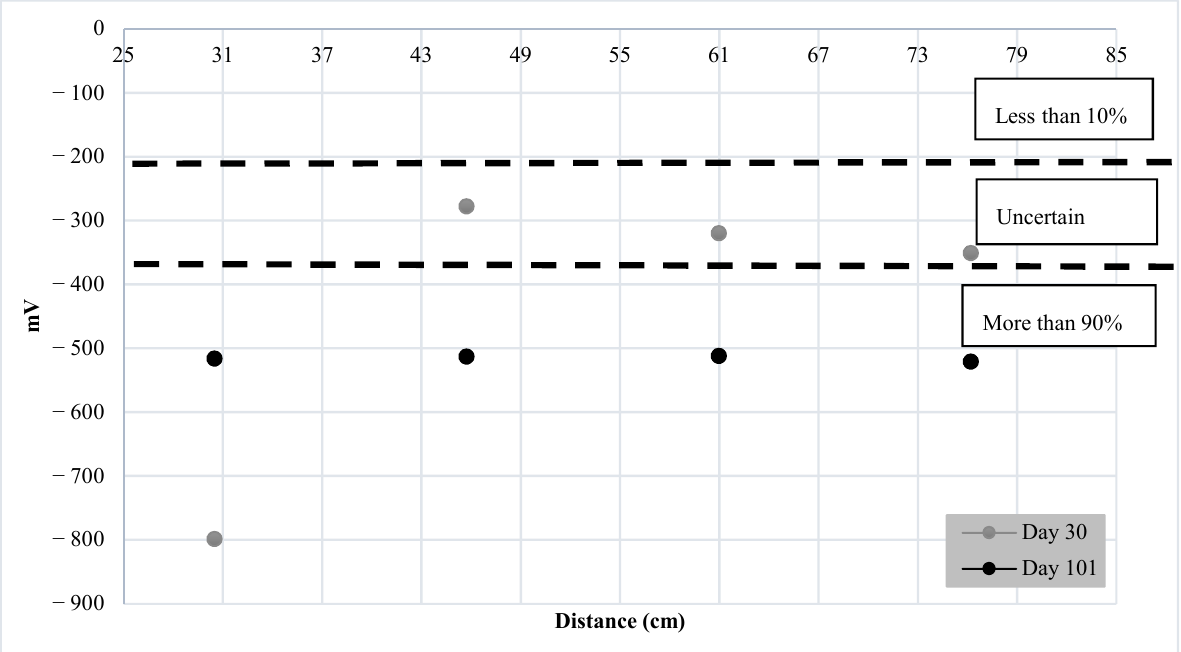
Figure 11. HCP measurements for Specimen A.